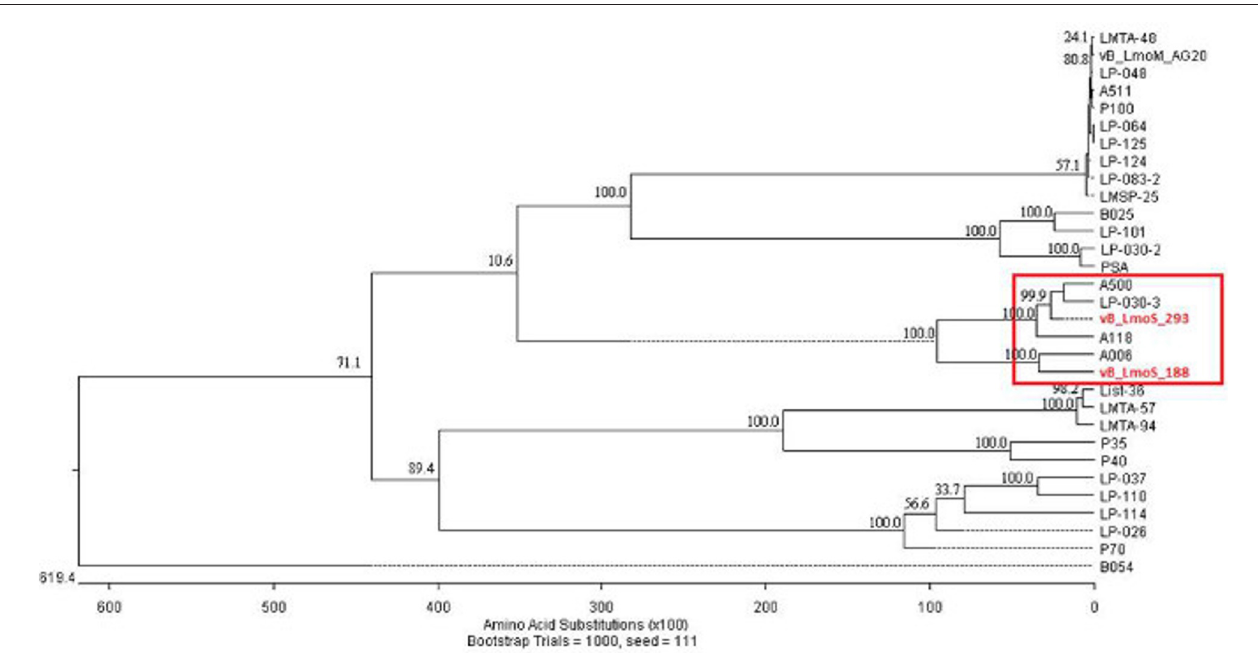
FIGURE 3 | Phylogenetic analysis of phages vB_LmoS_188, vB_LmoS_293 and other sequenced L. monocytogenes bacteriophages. The tree was generated in MegAlign (DNAStar); input sequences for ClustalW alignment consisted of whole proteomes of each bacteriophage.